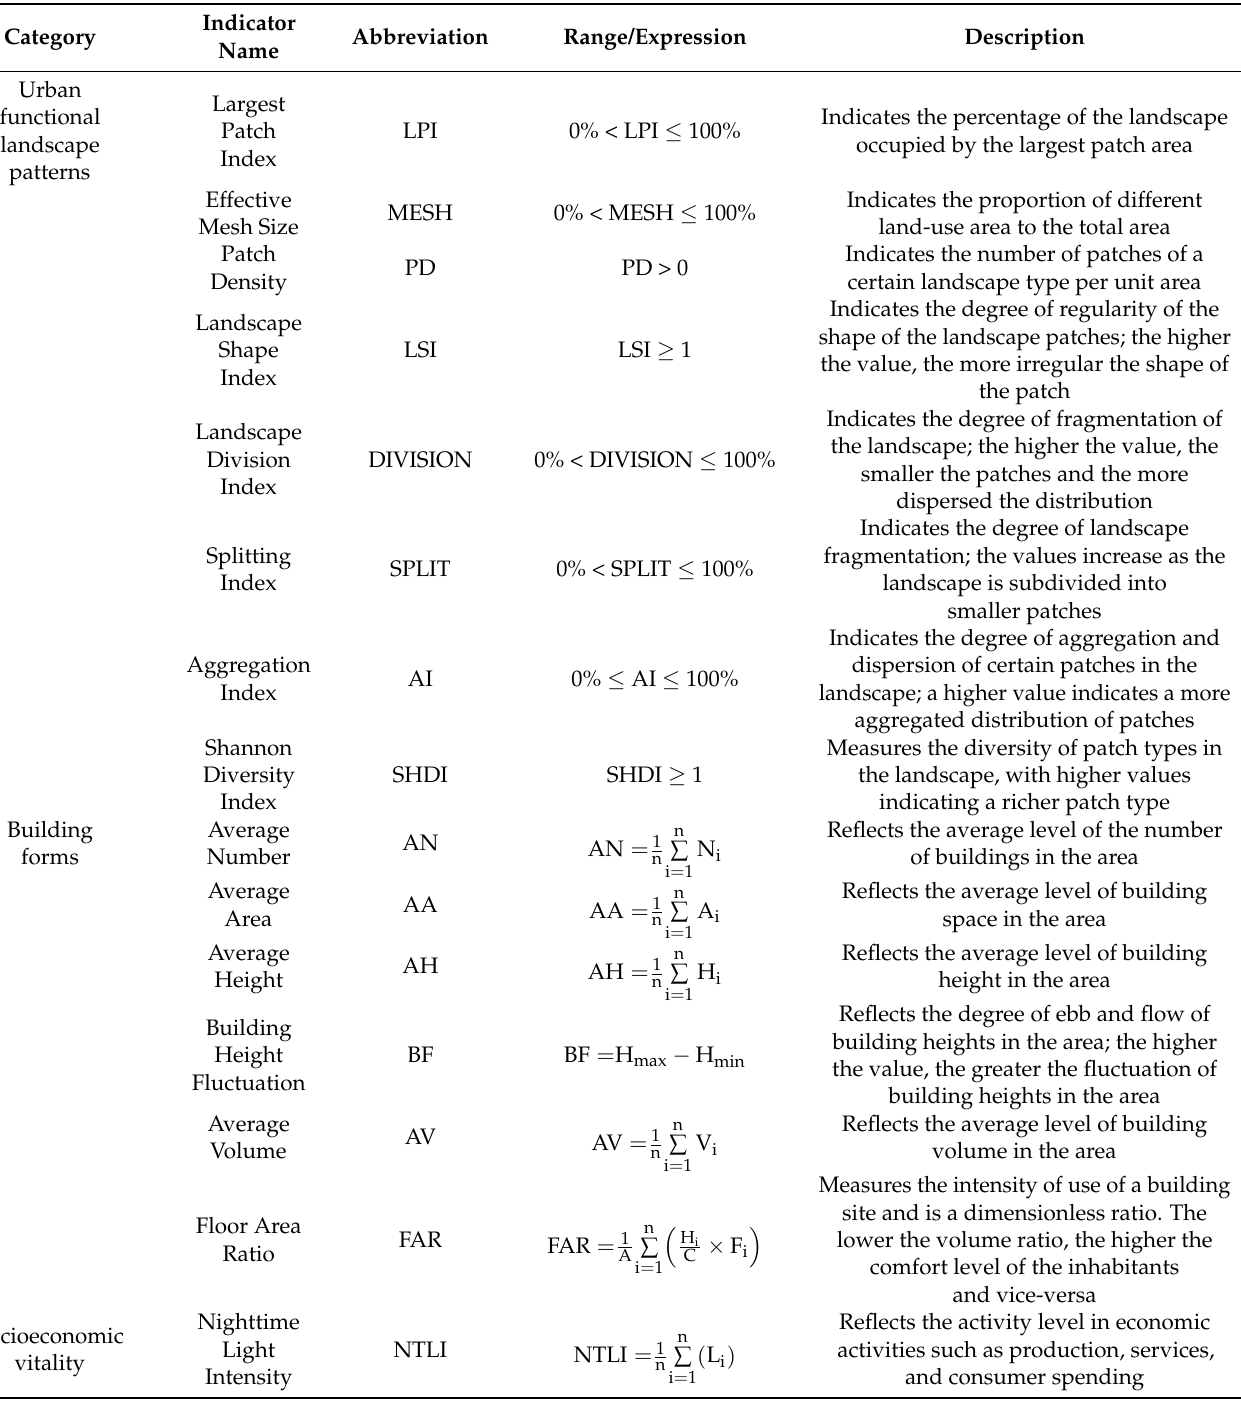
Table 2. Introduction of statistical analysis